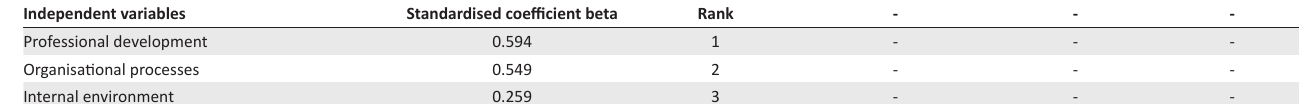
TABLE 5d: Ranking of standardised coefficient, beta ( β ). Independent